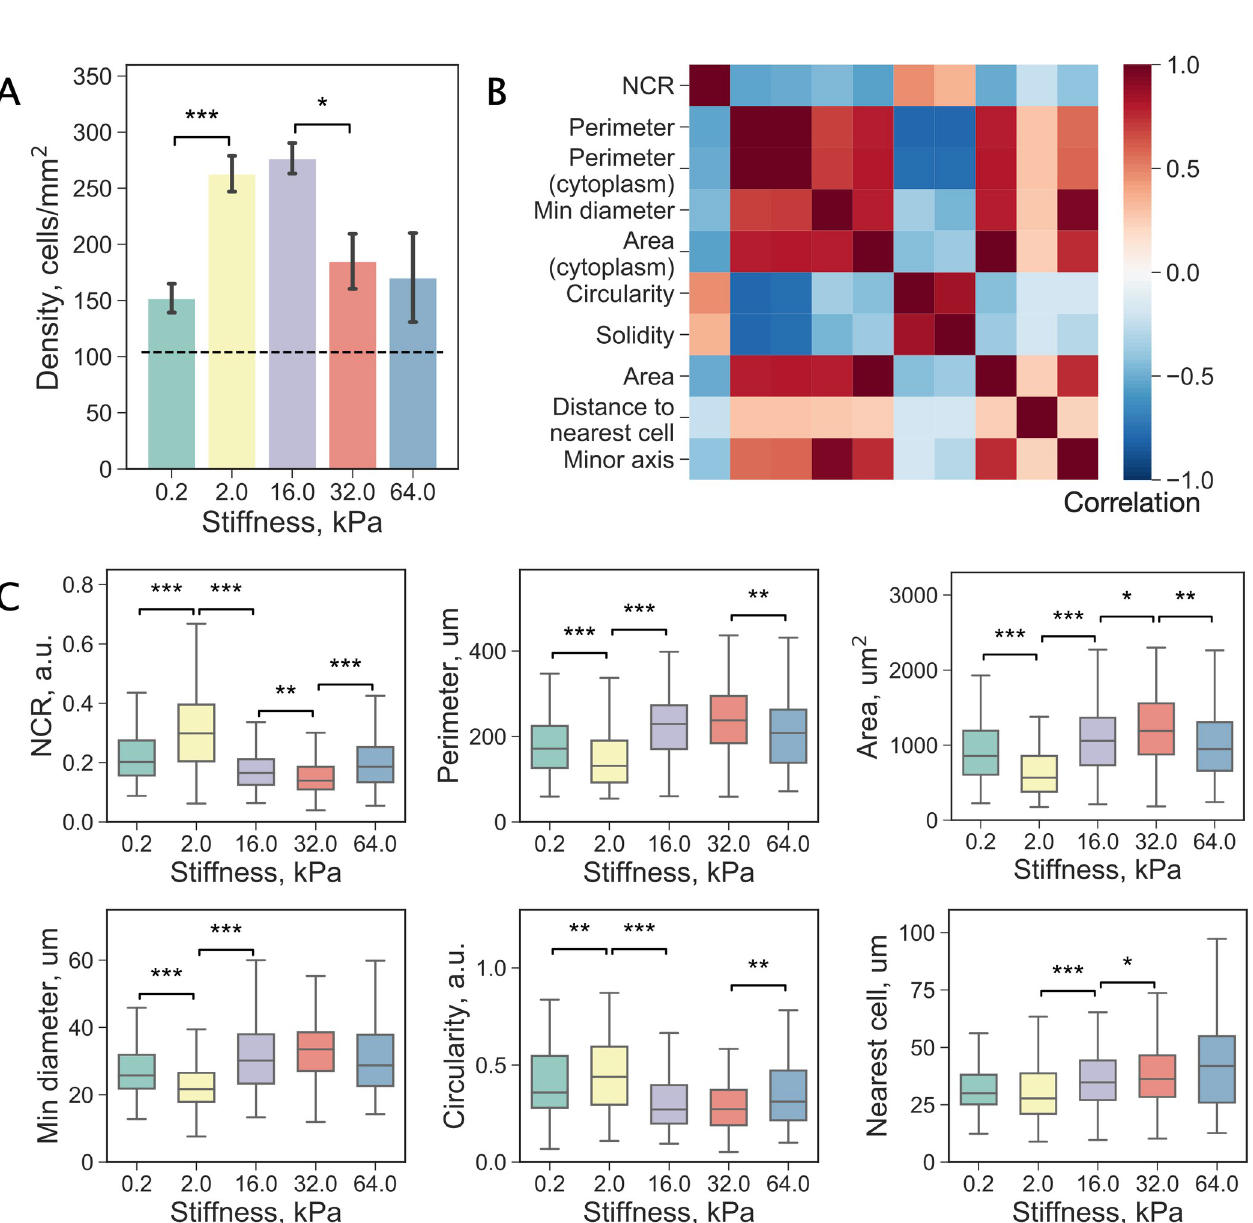
Fig 3. Distinct adaptations to substrate stiffness by TNBC cells. (a) An increase in cell density compared to baseline (dashed line) after cells were cultured for 24 hours on substrates with different stiffness values, n = 4 replicates per stiffness value. (b) Analysis of the association between the top 10 parameters modulated by substrate stiffness. Most measurements are related and thus are highly correlated with each other. (c) Changes in the distributions of NCR, cell perimeter, area, smallest diameter, circularity, and distance to the nearest cell in response to substrate stiffness. Distributions are reported using box plots: a box shows the median value, first and third quartiles, whiskers indicate median +/-1.5 � IQR. Significance of the difference assessed by Welch’s t-test (‘ ��� ’: p < 0.001, ‘ �� ’: p < 0.01, ‘ � ’: p < 0.05), n = number of cells, see Table A in S2 Text.